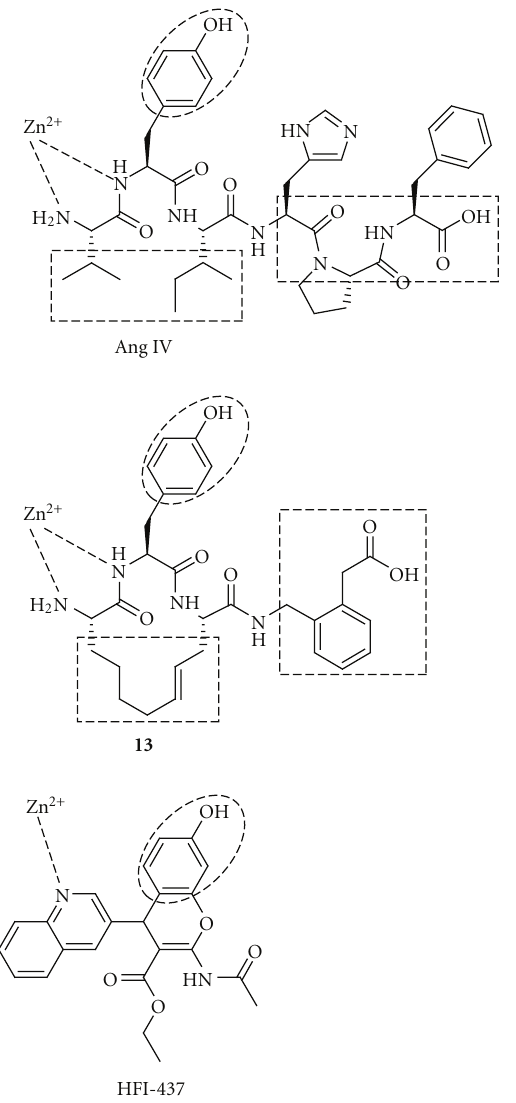
Figure 15: Ang IV, a peptidomimetic ( 13 ) and a non-peptidic (HFI- 437) IRAP inhibitor. The rectangles and circles show proposed recognition elements important for interaction with